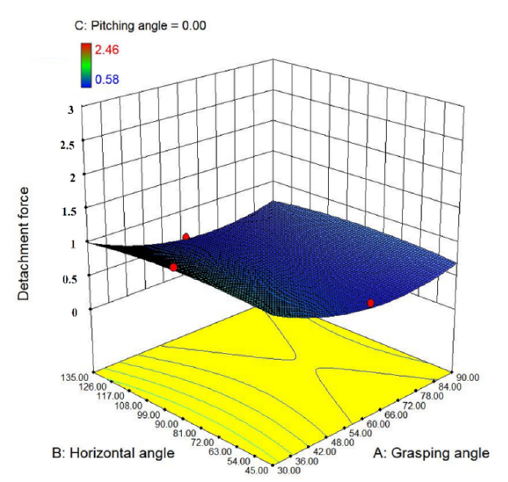
Figure 5. 3D desirability plot.